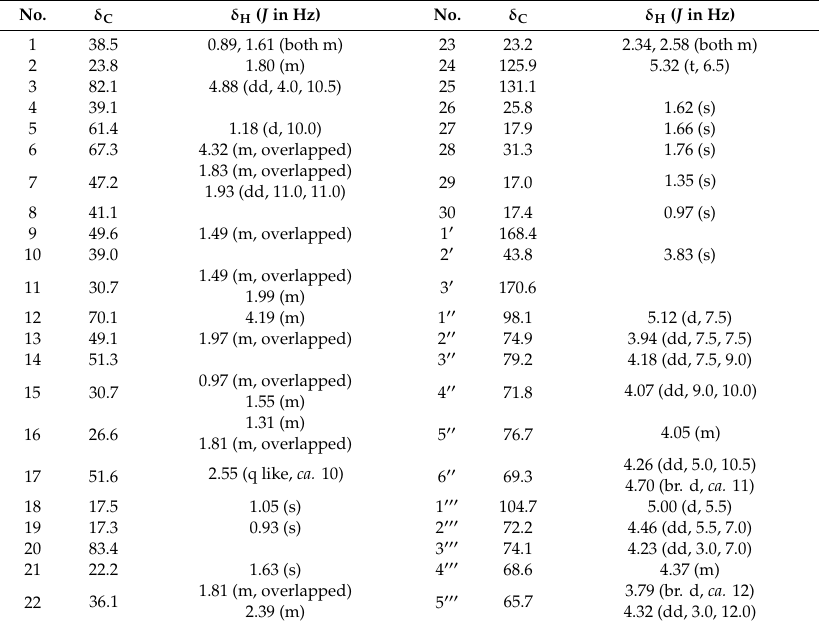
Table 11. The 1 H and 13 C-NMR data for 11 in C 5 D 5